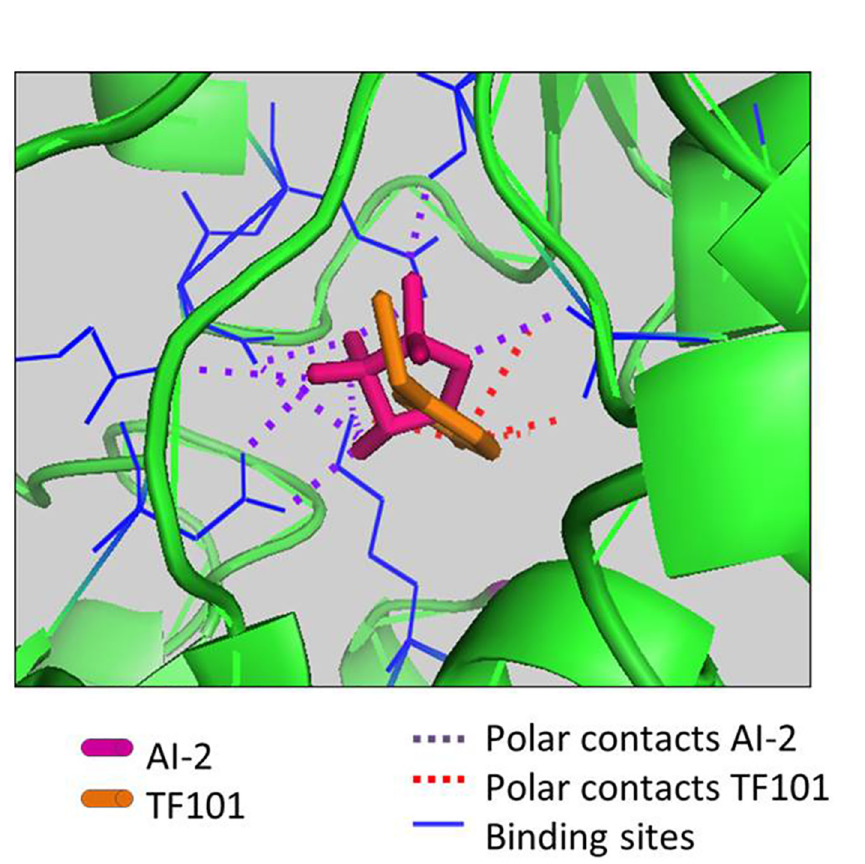
Fig 3. In silico interaction of TF101 and AI-2 with the LsrB receptor. In silico analyses predicted possible protein ligand interaction of TF101 and the LsrB receptor, indicating that TF101 might act as a competitive antagonist for the AI-2